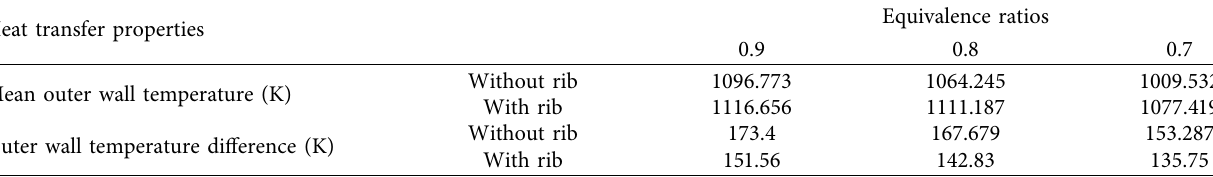
Table 4: Results of two types of micro-combustors under different equivalence